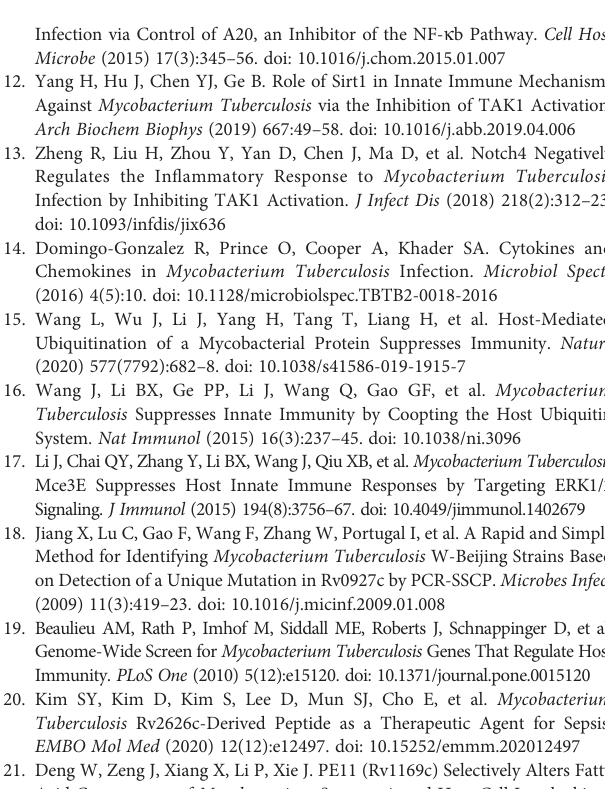
assay was performed to assay M. smegmatis survival. * P < 0.05 and ** P < 0.01 (unpaired two-tailed Student ’ s t test). Data are representative of one experiment with two independent biological replicates (mean and sem of n = 3 cultures). Supplementary Figure 3 | Effect of Rv0927c on p65, p38, Erk, jnk, I k B a and TAK1 phosphorylation levels and NF- k B luciferase activity in macrophages stimulated with several TLR ligands. (A, B) RAW264.7 cells were infected with M. smegmatis (MOI= 10) together with the recombinant Rv0927c protein (5 m g/ml) for the indicated time. Total protein was extracted and examined by immunoblot analysis. (B) RAW264.7 cells were transfected with Rv0927c or empty vector, as well as NF- k B reporter plasmid plus pRL-TK. Cells were stimulated with ligands for TLR2 (PGN), TLR1/2 (Pam3CSK4), TLR3 (Poly(I:C)), TLR4 (LPS), TLR7/8 (R848), and TLR9 (ODN1826), following 24 h transfection. Luciferase activity in cellular extracts was measured. ** P < 0.01 (unpaired two-tailed Student ’ s t test). Data are representative of experiments with at least three independent biological replicates (mean and sem of n = 3 cultures). Supplementary Figure 4 | Effect of 30 amino acids at the N-terminus of Rv0927c on NF- k B activation and effect of Rv0927c on LPS-induced nuclear translocation of p65. (A) Nucleic acid sequences encoding amino acids 31 − 263 (Lane 1), 61 − 263 (Lane 2), 91 − 263 (Lane 3), 121 − 263 (Lane 4), 151 − 263 (Lane 5),